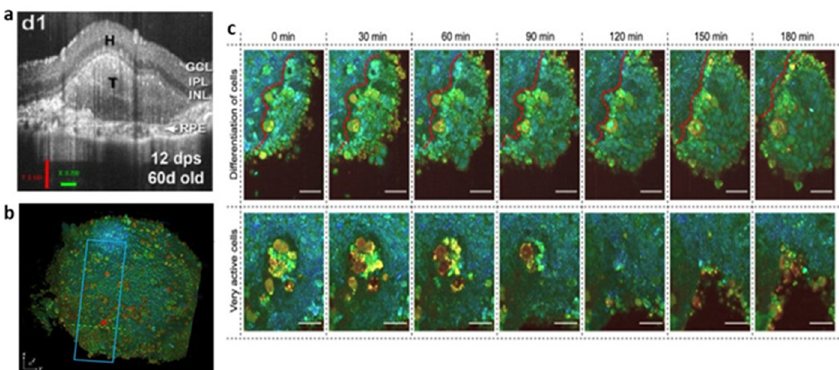
Figure 4. ( a ) In vivo development of retinal organoid transplant monitored by OCT. Reproduced from Reference [171] under the Creative Commons License (CC BY 4.0); ( b , c ) D-FFOCT 3D image ( b ) differentiation process is shown in the top row and the cell’s dynamic active region is shown in the bottom row ( c ) of hiPSC-derived retinal organoids. Reproduced from Reference [173] under the